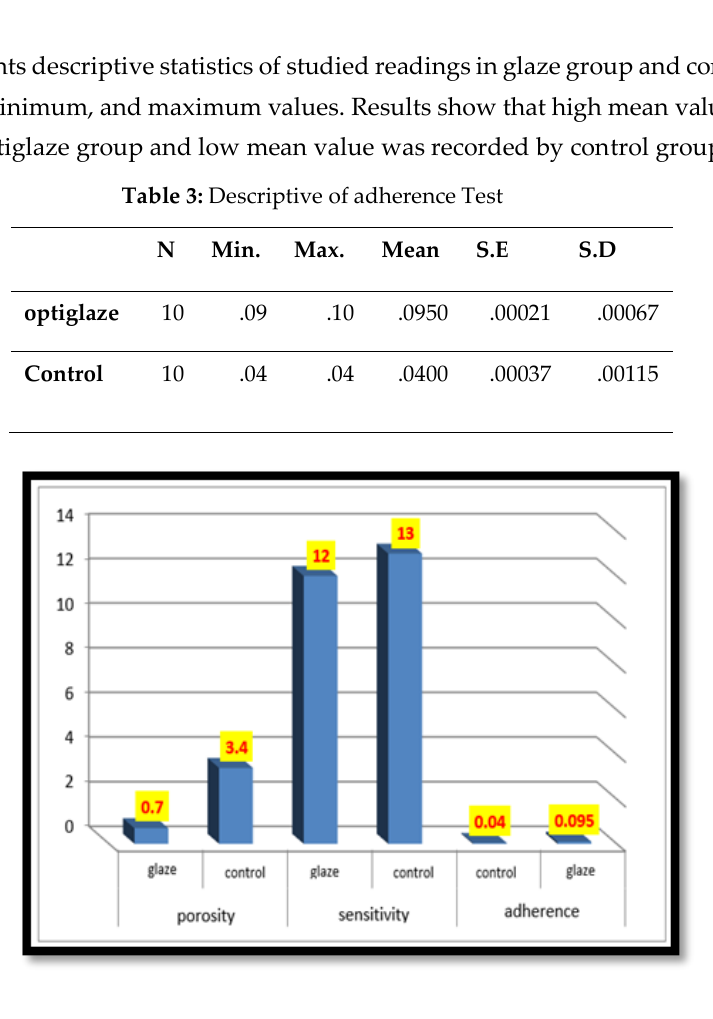
Figure 4: Bar Chart for" mean values" of control and optiglaze group for porosity, sensitivity and adherences